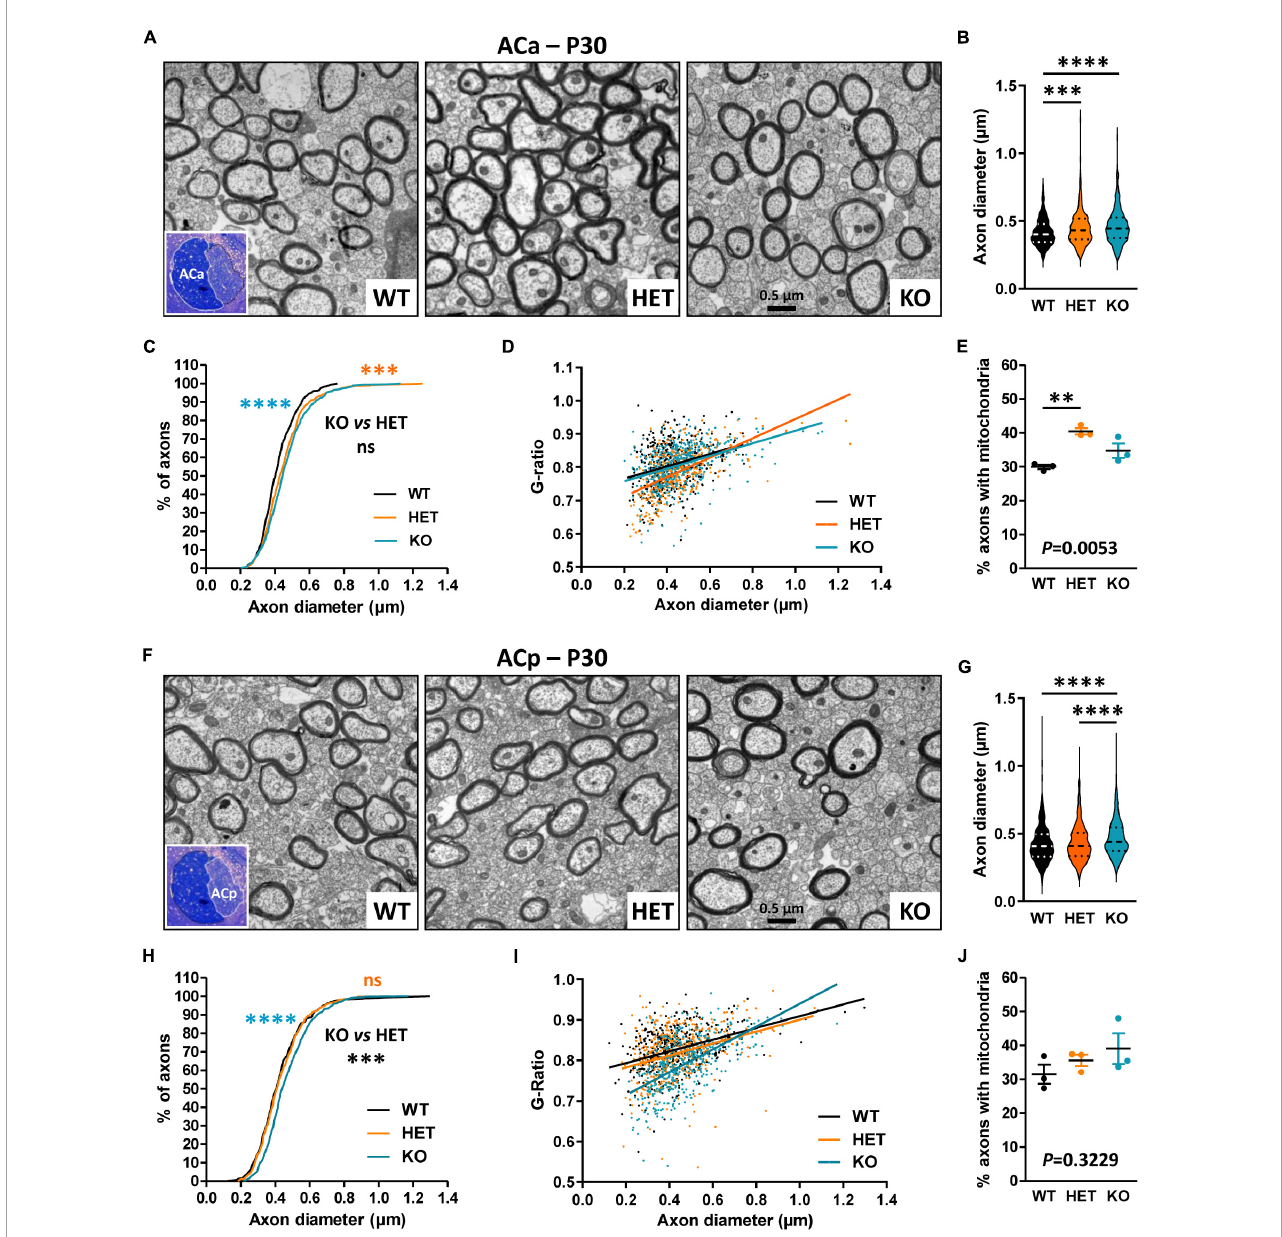
FIGURE5 Ultrastructural abnormalities of anterior branch (ACa) and posterior branch (ACp) myelinated fibers in P30 mice. Electron micrographs of transversal sections of the ACa (A) and ACp (F) at brain midline, from wild-type (WT), HET, and KO P30 mice; insets, semi-thin transversal sections of the AC stained with toluidine blue, showing the ACa and the ACp. Axonal diameters of ACa (B) and ACp (G) myelinated fibers. Cumulative frequency distribution of axonal diameters (in %) of ACa (C) and ACp (H) myelinated fibers. Scatter plot graphs displaying G-ratios of individual myelinated axons as a function of the respective axon diameters, and the linear regression of the G-ratio measurements for each genotype, for the ACa (D) and the ACp (I) . Percentage of myelinated axons containing mitochondria in the ACa (E) and the ACp (J) . (B–D,G–I) 441 myelinated fibers/genotype, 3 mice/genotype, 147 myelinated fibers/mouse; (E) 3 mice/genotype, % of mitochondria counted on ∼ 2000 axons/mouse; (J) 3 mice/genotype, % of mitochondria counted on ∼ 1000 axons/mouse. Statistical tests: (B,G) Mann–Whitney test to compare HET or KO mice to WT mice, and Kruskal–Wallis test to compare the three genotypes; (C,H) Kolmogorov–Smirnov test for pairwise comparisons; (D) Linear regression (WT R 2 = 0.08121, HET R 2 = 0.3458, KO R 2 = 0.1727) for pairwise comparisons, HET vs. WT slope P = 0.0024, HET vs. KO slope P = 0.0003; (I) Linear regression (WT R 2 = 0.1589, HET R 2 = 0.1062, KO R 2 = 0.3420) for pairwise comparisons, HET vs. WT elevation P = 0.0047, KO vs. WT slope P < 0.0001, HET vs. KO slope P < 0.0001; (E,J) Unpaired t -test (E) or Mann–Whitney test (J) to compare HET or KO mice to WT mice, and one-way ANOVA test (E) or Kruskal–Wallis test (J) to compare the